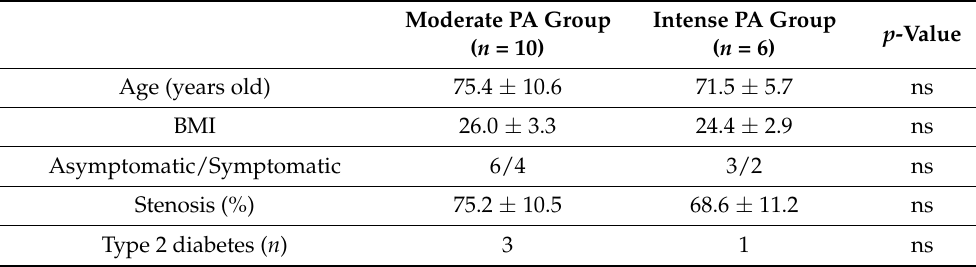
Figure 2. Monocyte phenotypes for each PA level groups ( A – C ) and PA intensity group ( D – F ), in comparison with healthy subjects. Patients were classified in three groups depending on the weekly level of PA (group 1: n = 10; 586 ± 377 MET.min/week; group 2: n = 9; 3233 ± 781 MET.min/week; and group 3: n = 7; 5457 ± 757 MET.min/week). ( A ) Classical monocytes frequency; ( B ) intermediate monocytes frequency; and ( C ) non-classical monocytes frequency. Patients were stratified in two groups depending on the weekly intensity of PA (moderate group: n = 9, involved in moderate (4 MET.min/week) PA; intense group: n = 6 involved in moderate to intense (4 MET.min/week to 8 MET.min/week) PA. ( D ) Classical monocytes frequency; ( E ) intermediate monocytes frequency; and ( F ) non-classical monocytes frequency. Rate of each monocytes phenotype is expressed as a percentage of the total monocytes count. Parametric statistical analysis was done on data represented on graph ( A , C ), thus, mean and standard deviation are represented in dashed and blue lines. Non- parametric statistical analysis was done on data represented on graph ( B , D – F ), thus, median and interquartile range are represented in continuous black lines. MET: Metabolic Equivalent of Task; min: minute; PA: Physical activity. * p < 0.05 between patient groups. ** p < 0.01 between patient groups. In red: ¤ p = 0.06 difference with the healthy donor group. $ p < 0.05 difference with the healthy donor group. $$ p < 0.01 difference with the healthy donor group. Table 3. Physical activity intensity groups risk factors, comorbidities, and complete blood count. BMI: body mass index; PA: physical activity and ns: